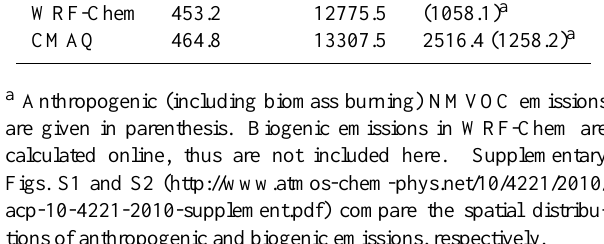
Figs. S1 and S2 (http://www.atmos-chem-phys.net/10/4221/2010/ acp-10-4221-2010-supplement.pdf) compare the spatial distribu- tions of anthropogenic and biogenic emissions,